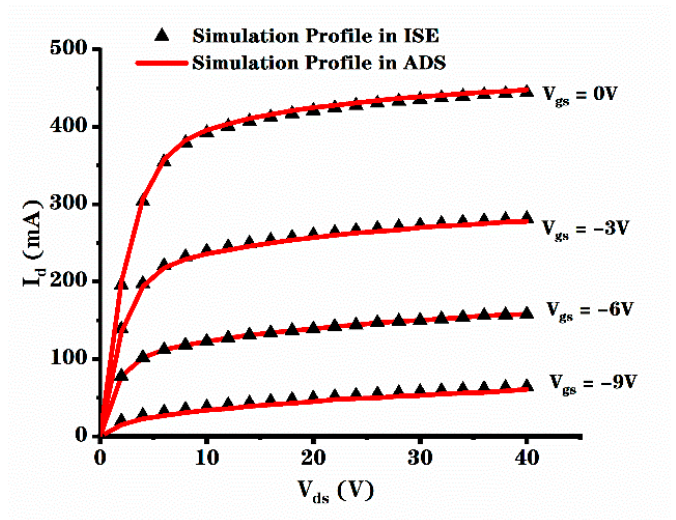
Figure 2. Comparison of simulation data in ISE and ADS on output current. Table 1. Structure parameters of the devices.